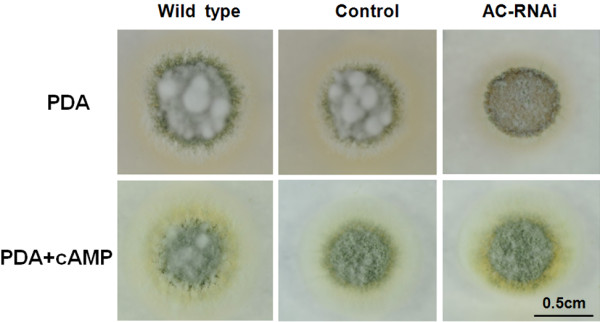
Exogenous addition of 8-Br-cAMP to the AC-RNAi mutant results in increased growth rates. The morphology of the wild type, knockdown control and AC-RNAi mutant colonies grown in the presence of 8-Br-cAMP (5 mM) were inoculated on PDA medium. These cultures were grown for 5 d prior to documentation. Scale bar: 0.5 cm.